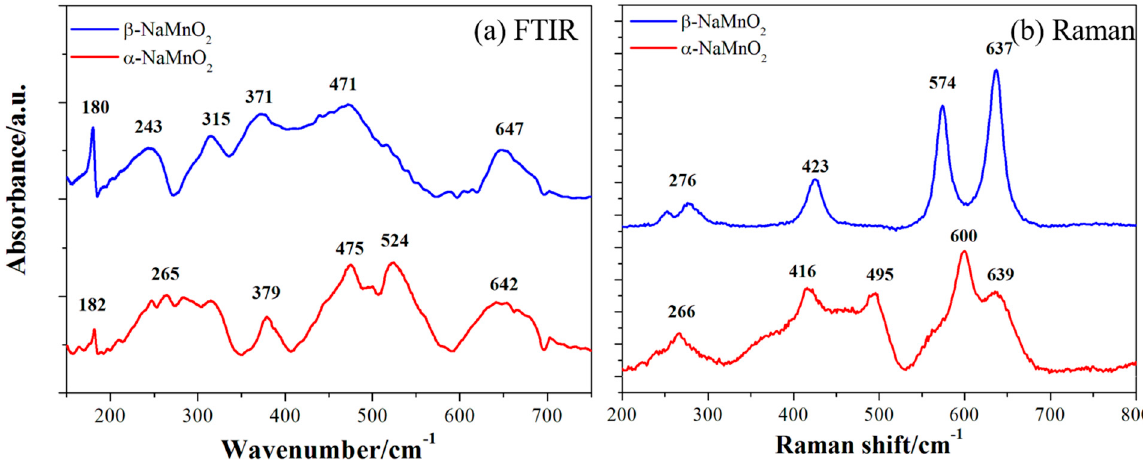
Figure 6. ( a ) Fast Fourier Transform Infrared spectroscopy (FTIR) and ( b ) Raman spectra of the α -NaMnO 2 and β -NaMnO 2 phases.